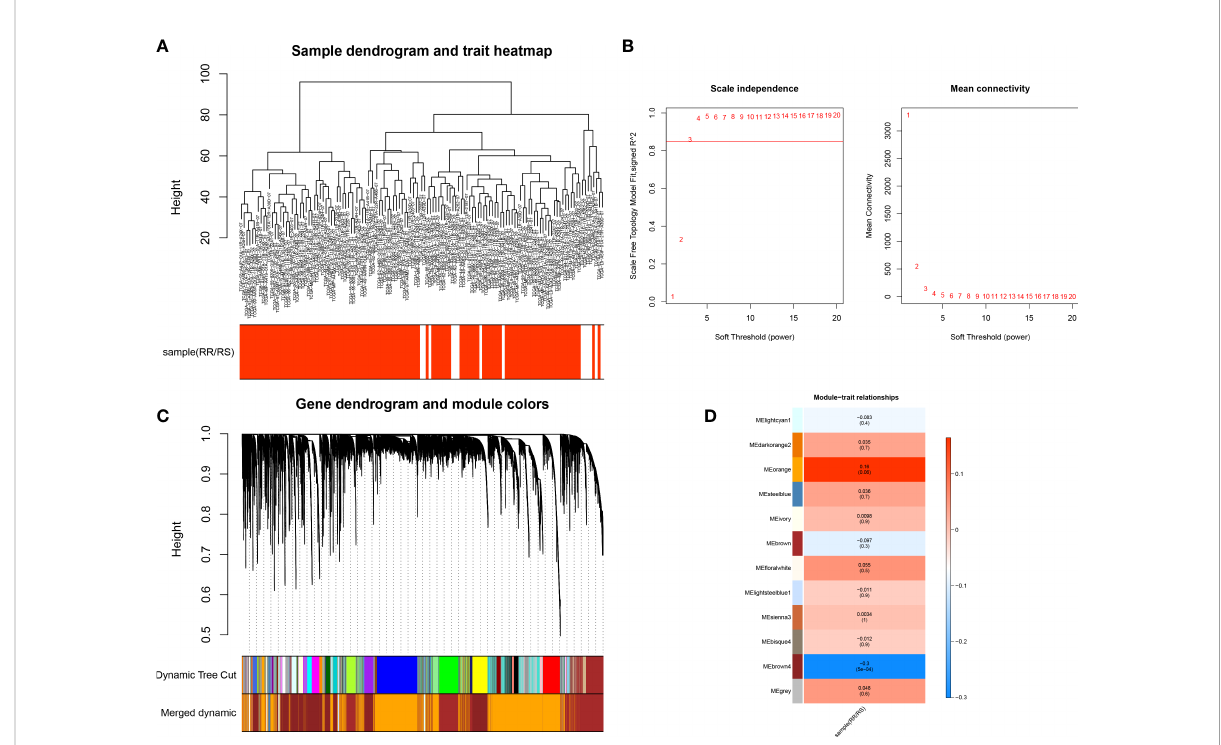
FIGURE 2 Identi fi cation of key genes in the radiotherapy of LUAD. (A) Sample Clustering Chart. (B) Selection of the optimal soft threshold power. (C) Module clustering dendrogram. (D) Heat map of the relationship between gene modules and traits, using the type of radiotherapy effect as the